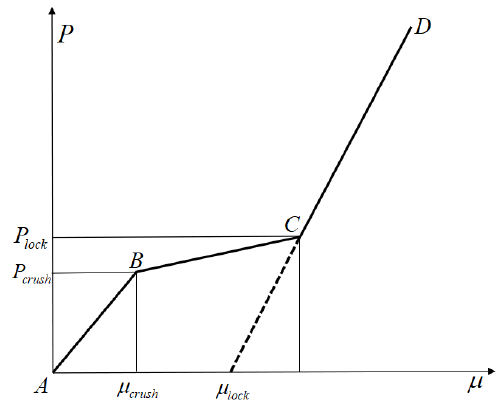
Figure 16. Equation of state curve of HJC.